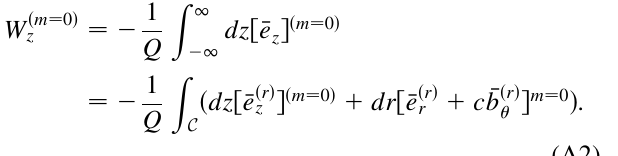
and arbitrary contour C and the two radial lines connecting between them r and r at z (cid:1) (cid:2)1 , respectively. The sign of contour (cid:9) C means that the direction of in out